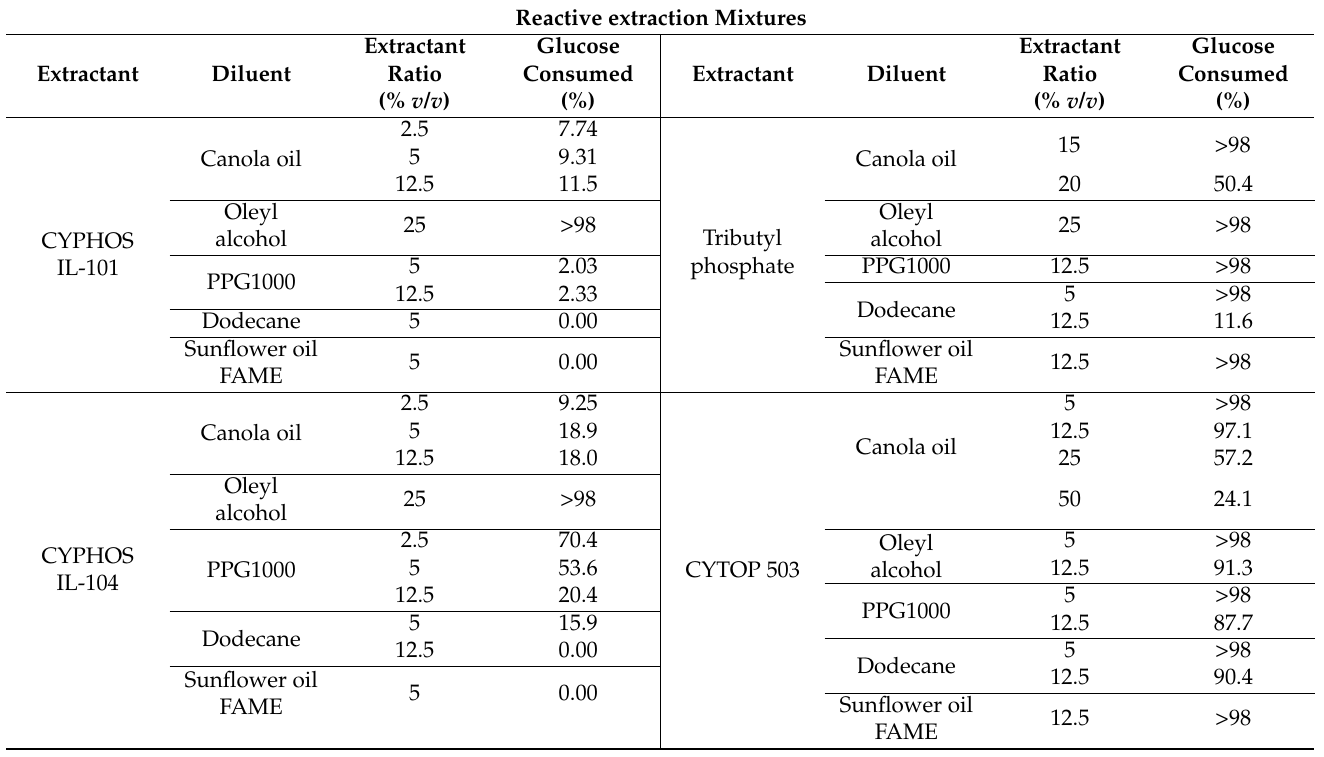
Table 2. Biocompatibility of the composed solvent mixtures. Reactive extraction